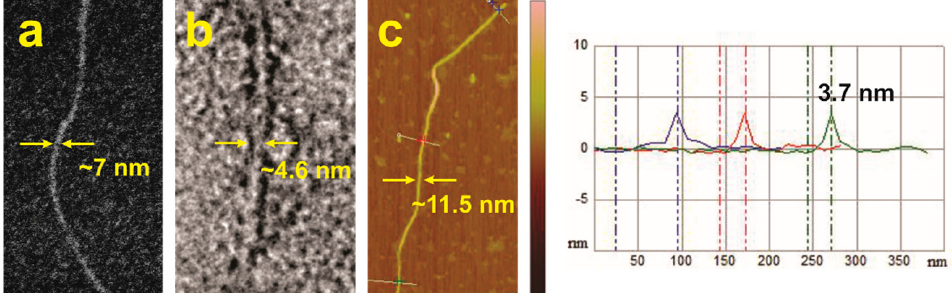
Figure 6. Microscopy images of elementary nanofibrils of ISA24 deposited from cyclohexane solution (0.1 wt%). ( a ) Scanning electron microscopy (SEM) image. ( b ) High–resolution transmission electron microscopy (HR–TEM) image. The contrast enhanced with a negative uranyl acetate stain. ( c ) Atomic force microscopy (AFM) height image (1.955 μ m × 1.065 μ m, vertical scale bar represents 0–10 nm) with a cross-sectional analysis across an individual elementary nanofiber in three different